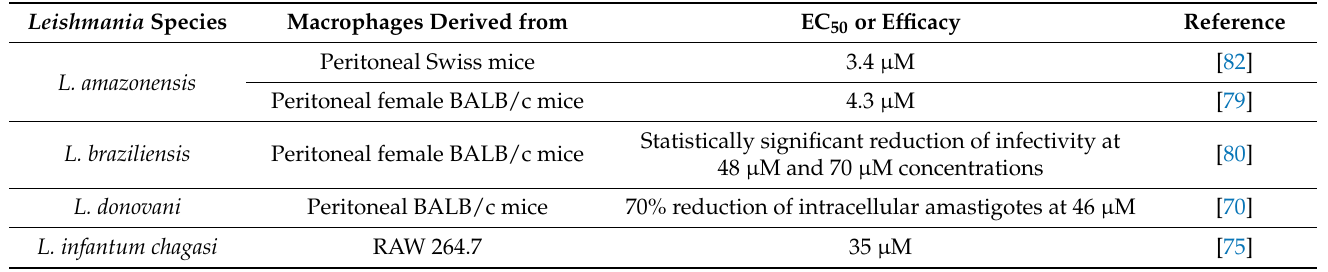
Table 4. In vitro activity of quercetin against intracellular